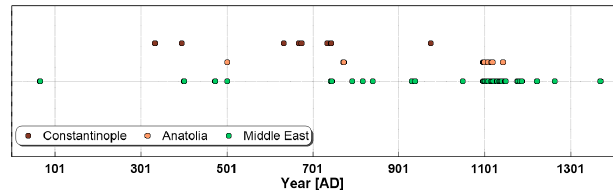
Figure 2. Plot of aurora observations recorded in the Constantino- ple, Anatolia, and Middle East regions.